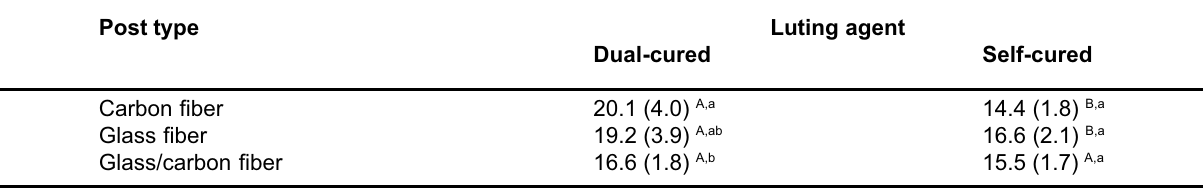
MORPHOLOGICAL ANALYSIS OF GLASS, CARBON AND GLASS/CARBON FIBER POSTS AND BONDING TO SELF OR DUAL-CURED RESIN LUTING TABLE 1- Microtensile bond strength means (standard deviations)